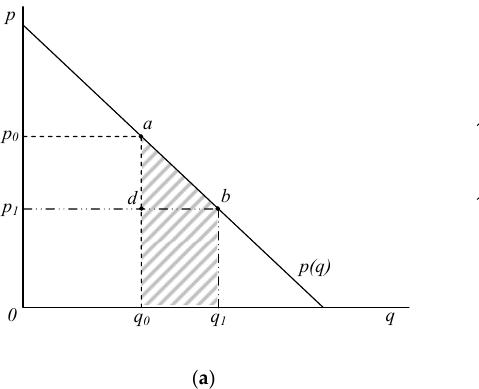
Figure 4. Consumer surplus Δ𝐶𝑆 (cid:3047) = (cid:2869) V is the value of time per time unit; ( a ) price reduction: 1 1 − τ + q ( τ t )( q t ) t 1 t 1 0 0 2